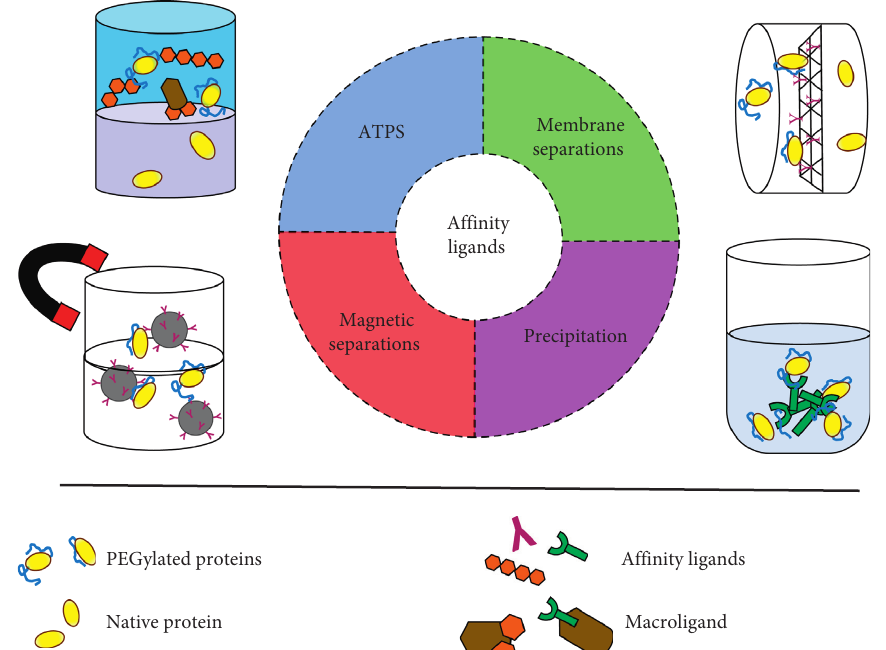
Figure 1: Potential nonchromatographic affinity-based strategies to be highlighted in the future recovery and purification of PEG-modified